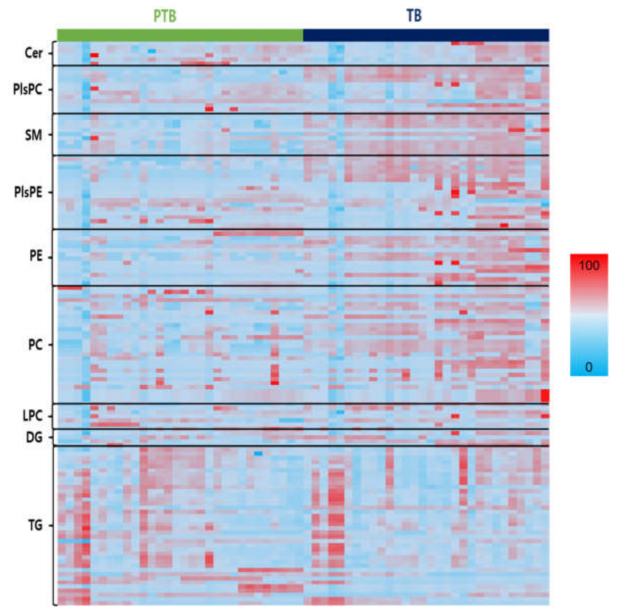
Figure 3. Heats maps representing all lipids between PTB and TB. Normalized expression of each lipid in PTB (n = 30) and TB (n = 30) are shown in scale range from blue to red.